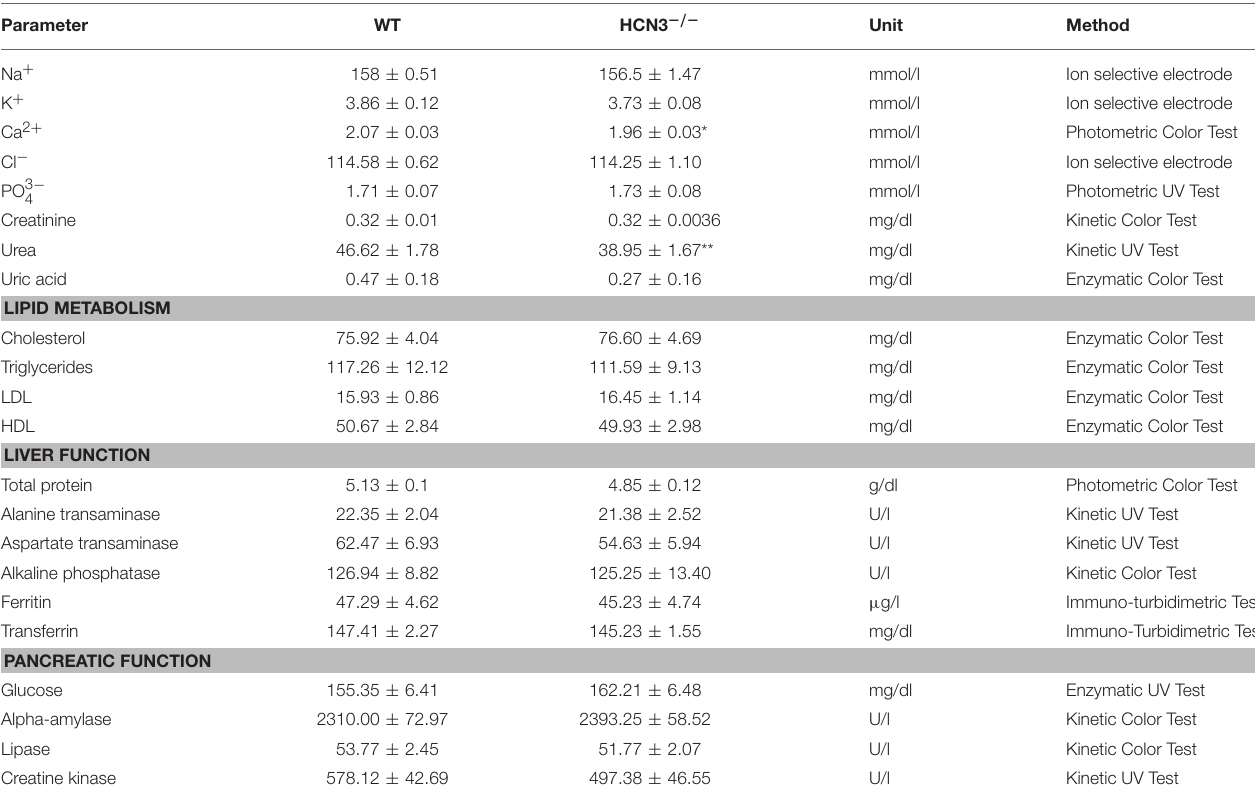
TABLE 1 | Blood plasma